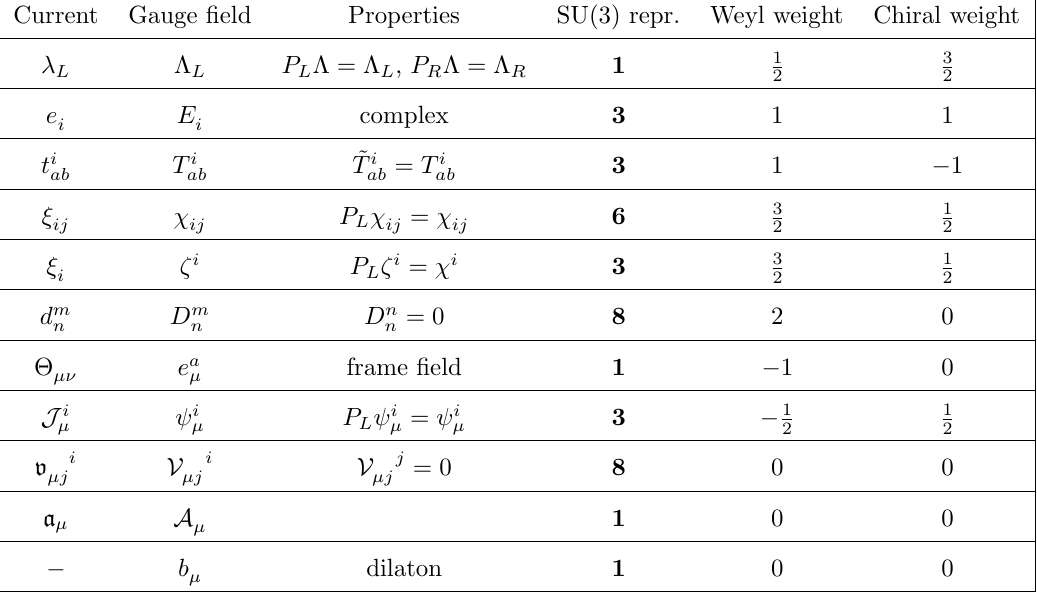
Table 4 . The multiplet of currents and their corresponding gauge/matter (cid:12)elds for N = 3 con- formal supergravity. The third column shows some properties of the gauge (cid:12)elds derived from the properties of the currents, the fourth column gives the R -symmetry representation of the currents (and (cid:12)elds) and the (cid:12)fth and sixth column respectively give the Weyl and chiral weights of the gauge/matter